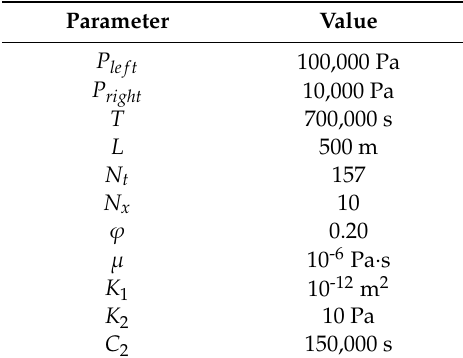
Table 2. Parameters for numerical calculations.